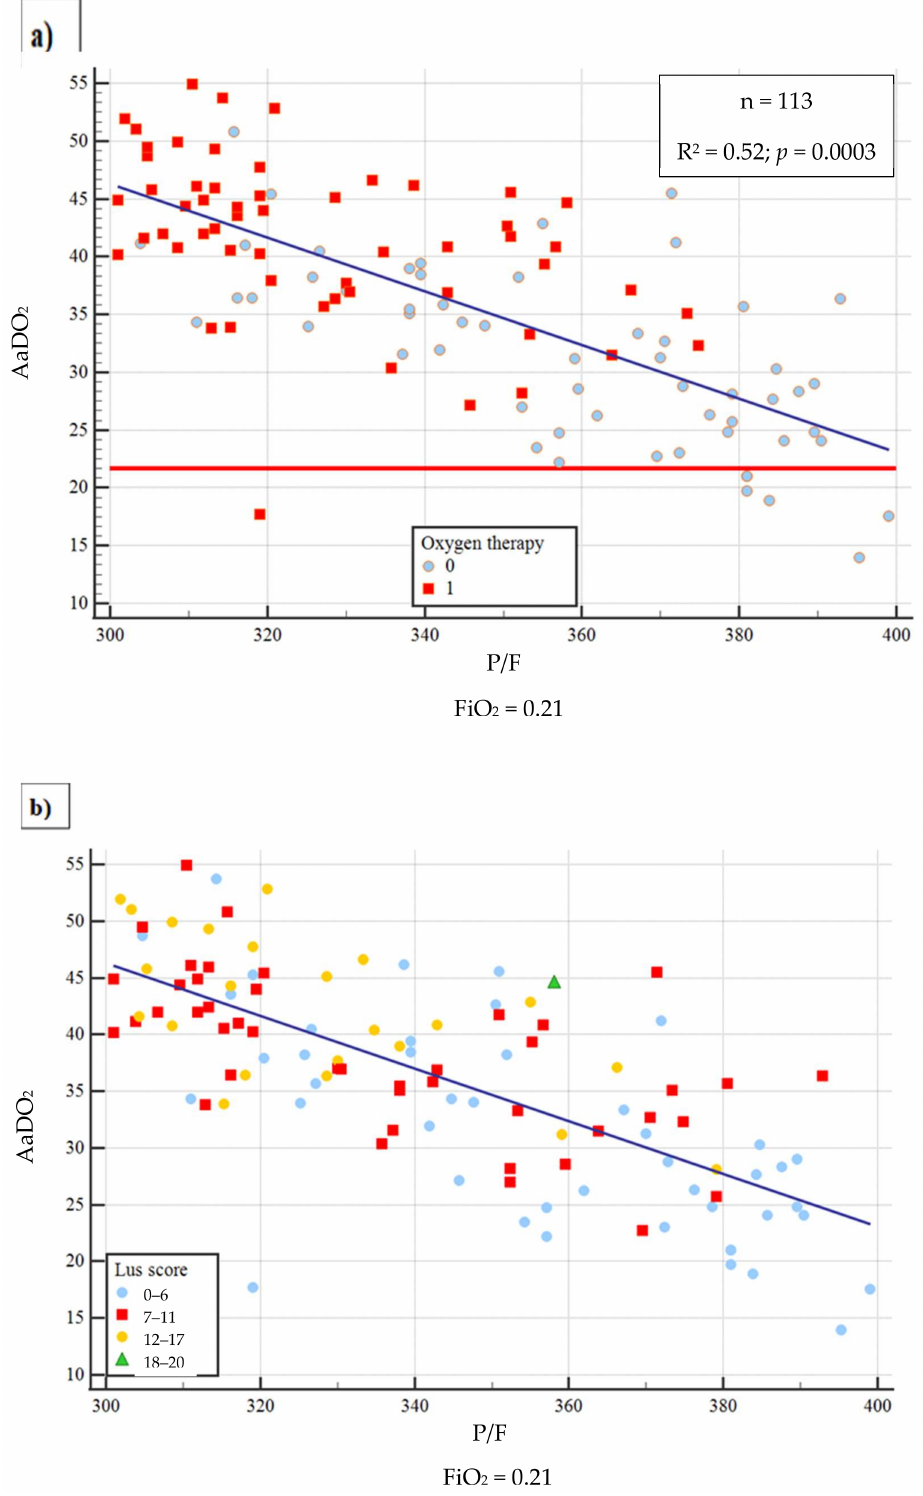
Figure 3. Distribution of AaDO2 values in the P/F 300–400 group. ( a ) Oxygen therapy ( b ) LUS score distribution: blue (0–6), red (7–11), orange (12–17) and green